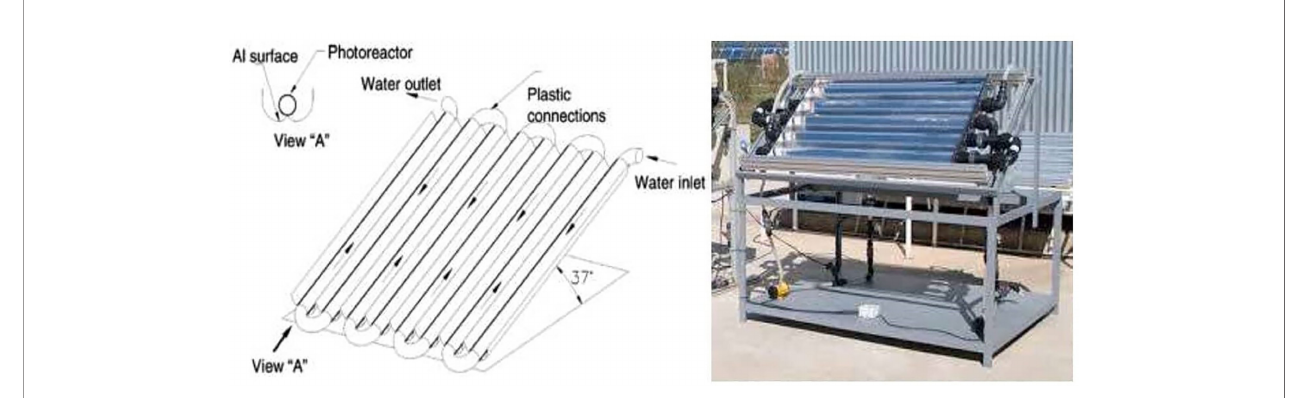
FIGURE 8 | Schematic drawing and picture of a compound parabolic collector (CPC). Reproduced with permission (Fendrich et al.,